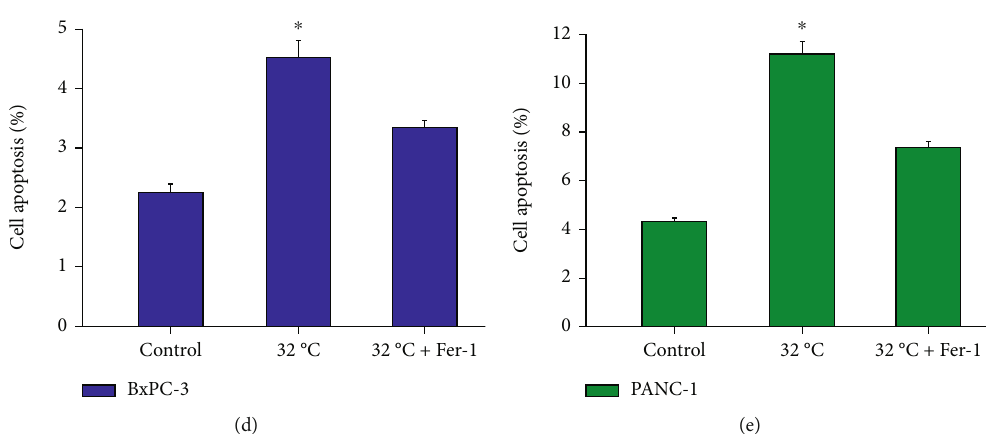
Figure 4: Cold induces ferroptosis to regulate the proliferation and apoptosis of pancreatic cancer cells. BxPC-3 and PANC-1 cells were cultured at 37 ° C (Control), 32 ° C, or treated with ferroptosis inhibitor Ferrostatin-1 (Fer-1) and then cultured at 32 ° C (32 ° C+Fer-1). The proliferation of BxPC-3 (a) and PANC-1 (b) cells was detected by CCK-8 assay. (c – e) Detection of apoptosis by fl ow cytometry. ∗ P < 0 : 05 versus